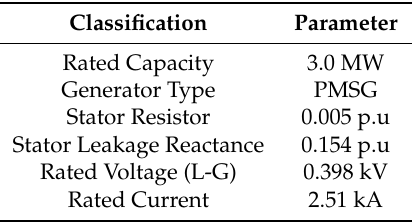
Table A1. The parameters for the PMSG wind turbine generator.